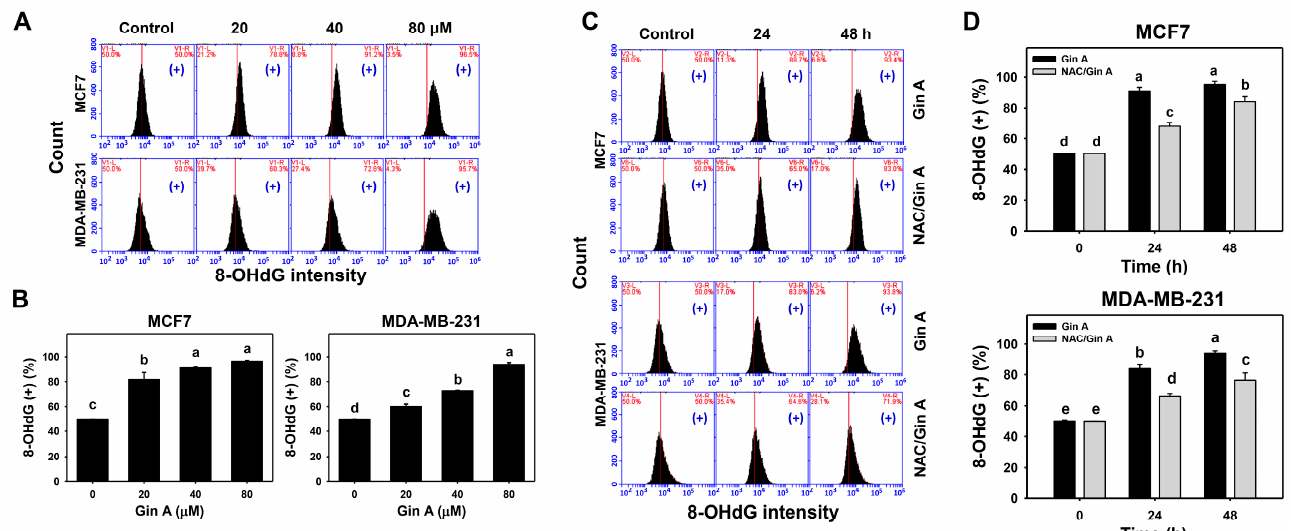
Figure 8. Impact of Gin A on 8-OHdG level in breast cancer cells. ( A , B ) 8-OHdG level. Cells were treated with 0 (0.1% DMSO; control), 20, 40, and 80 µ M Gin A for 48 h. Subsequently, they were subjected to 8-OHdG flow cytometry. (+) indicates 8-OHdG (+) populations. ( C , D ) NAC reverted effects on the 8-OhdG level. Cells were pretreated with NAC (10 mM) for 1 h and then post-treated with Gin A (control and 80 μ M) for 0, 24, and 48 h, namely NAC/Gin A. Data, means ± SDs ( n = 3). When the connecting letters are overlapping, their difference was significant for multiple comparisons ( p < 0.05 to 0.0001). For the example of MDA-MB-231 cells ( D ), Gin A at 0, 24, and 48 h showing e , b , and a differs significantly. NAC/Gin A at 0, 24, and 48 h showing e , d , and c differs significantly, whereas Gin A and NAC/Gin A at 0 h showing the overlapped letter e differ non-significantly.